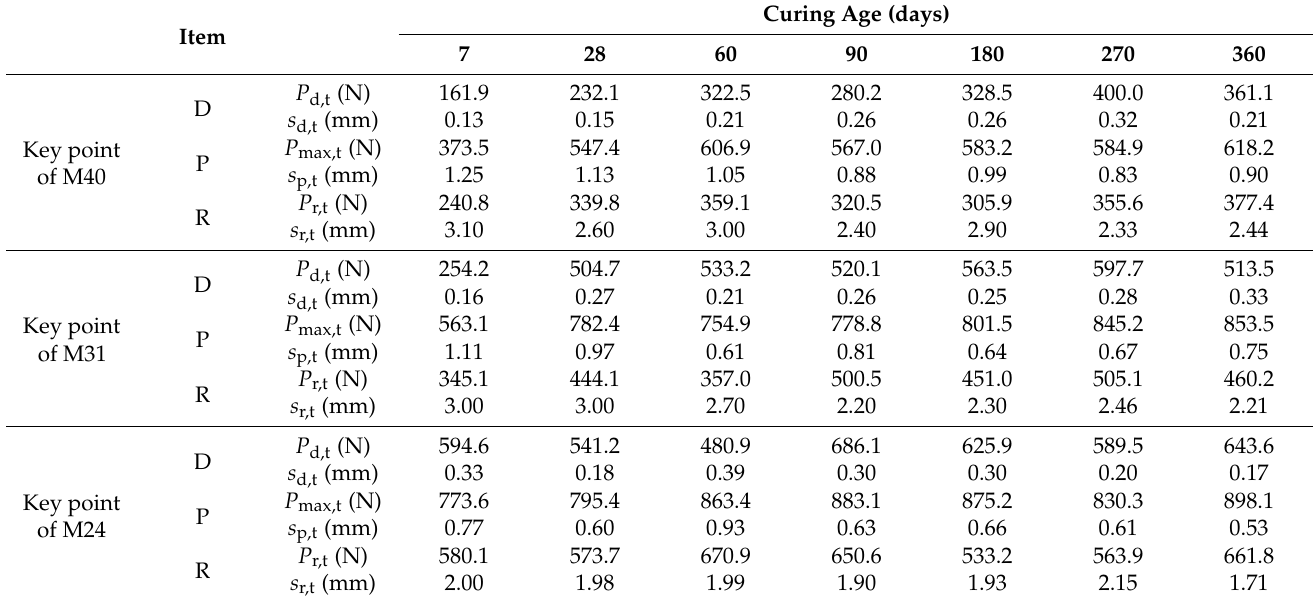
Table 3. The loads and slips at key points of the characteristic PL-S